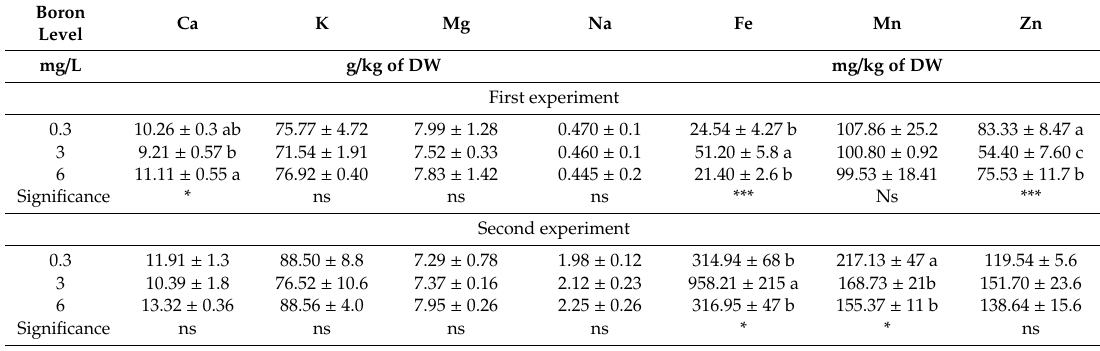
Table 2. E ff ects of di ff erent boron level in the nutrient solution the content of Ca, K, Mg, Na, Fe, Mn, and Zn in edible parts of wild (first experiment) and commercial (second experiment) purslane. Boron Ca K Mg Na Fe Mn Zn Level mg / L g / kg of DW mg / kg of DW